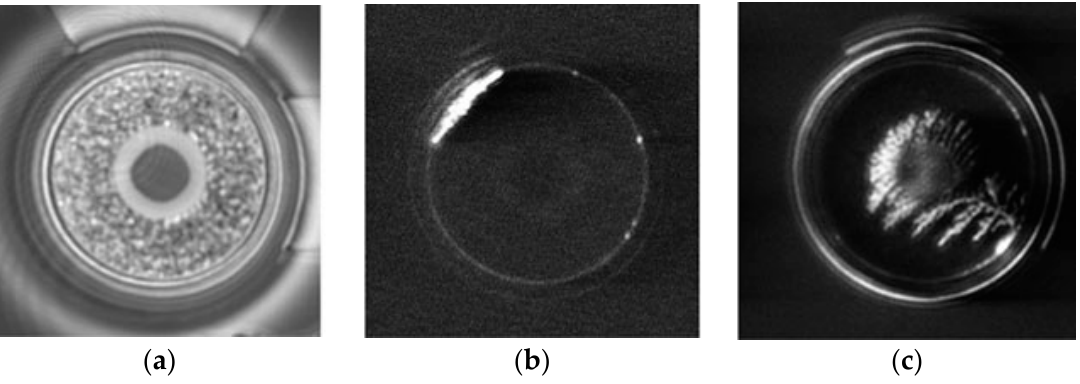
Figure 9. TIVA for detecting DLDs in VCSEL. ( a ) Reflected light image, ( b ) TIVA image of a normal VCSEL, and ( c ) TIVA image of a VCSEL damaged by aging test [67]. Reprinted with permission from ref. [67] © Springer Nature. Copyright 2013 Springer eBook.